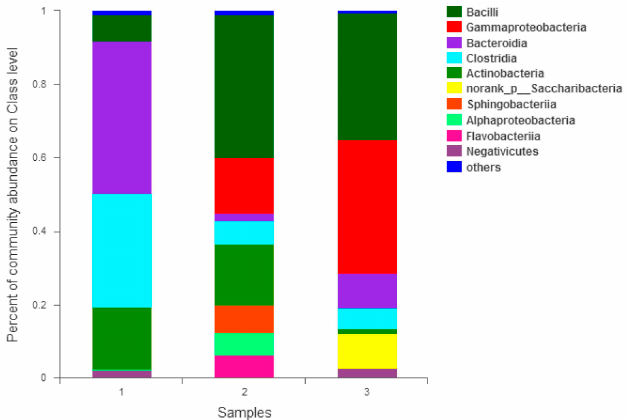
Figure 9. Community bar plot analysis.